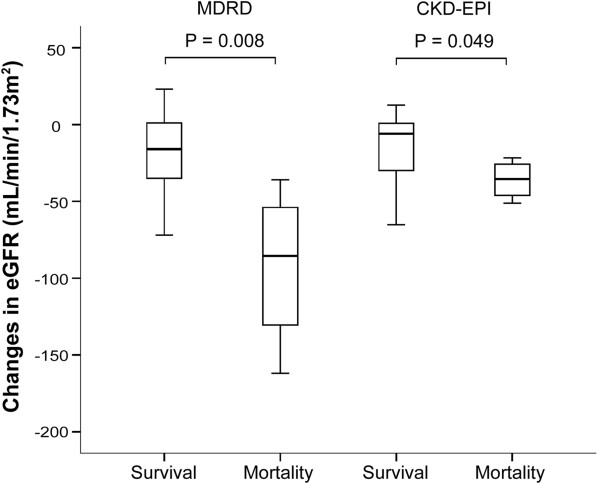
The comparison of changes (∆) from baseline to week 2 between the patients with survival and mortality in estimated glomerular filtration rate. Modification of diet in renal disease (MDRD), p=0.008 and Chronic Kidney Disease Epidemiology Collaboration (CKD-EPI), p=0.049. The boxplots showed the extreme values, 25th, 50th (median) and 75th percentiles and outliers.